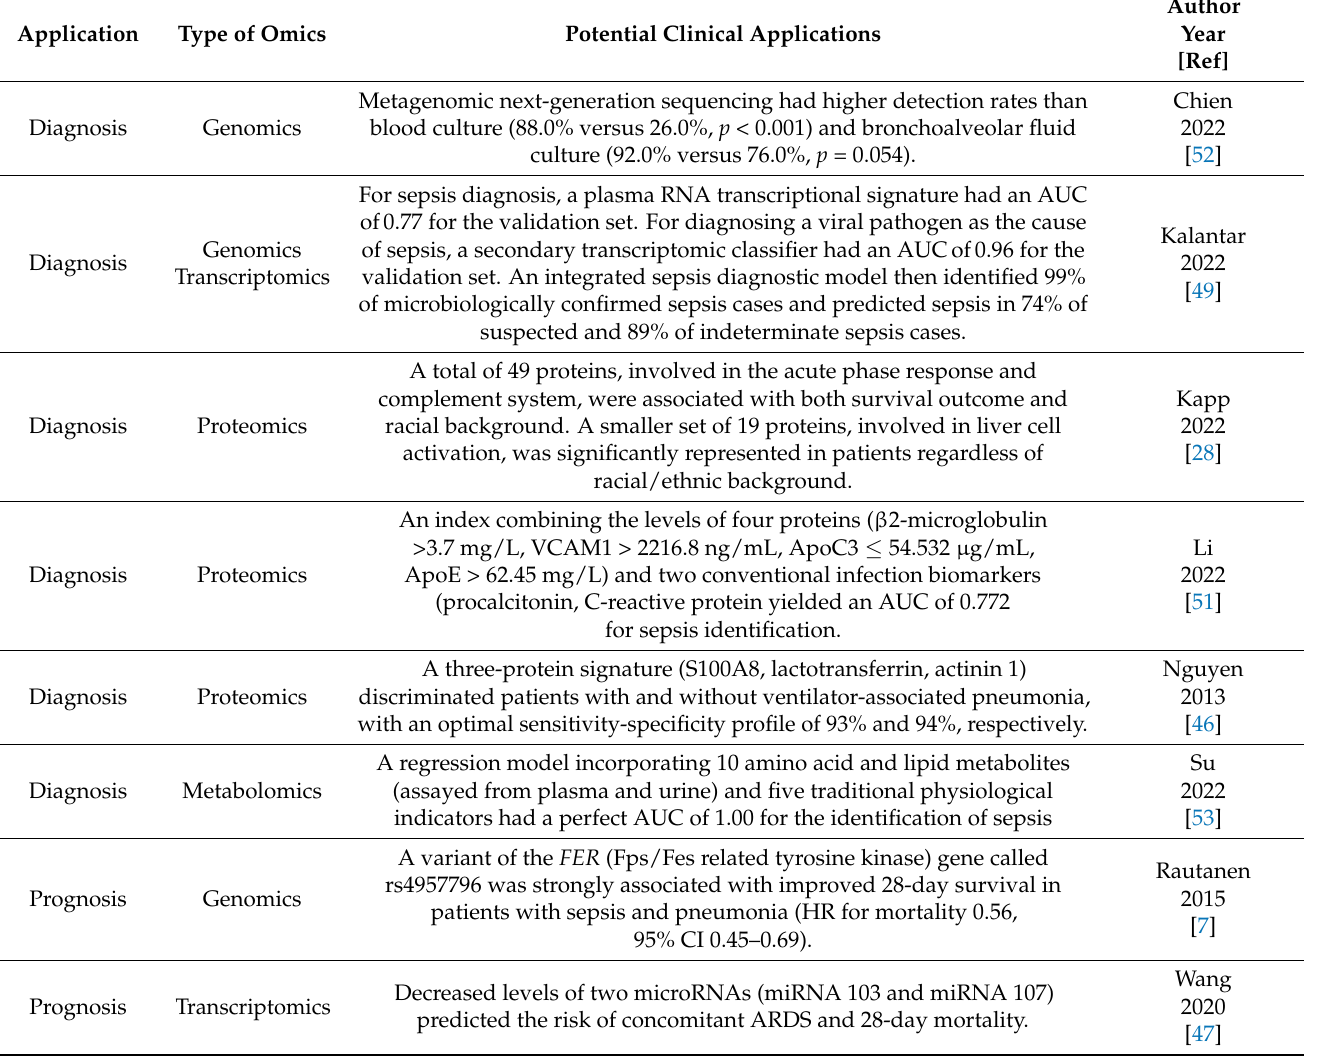
Table 3. Omics for